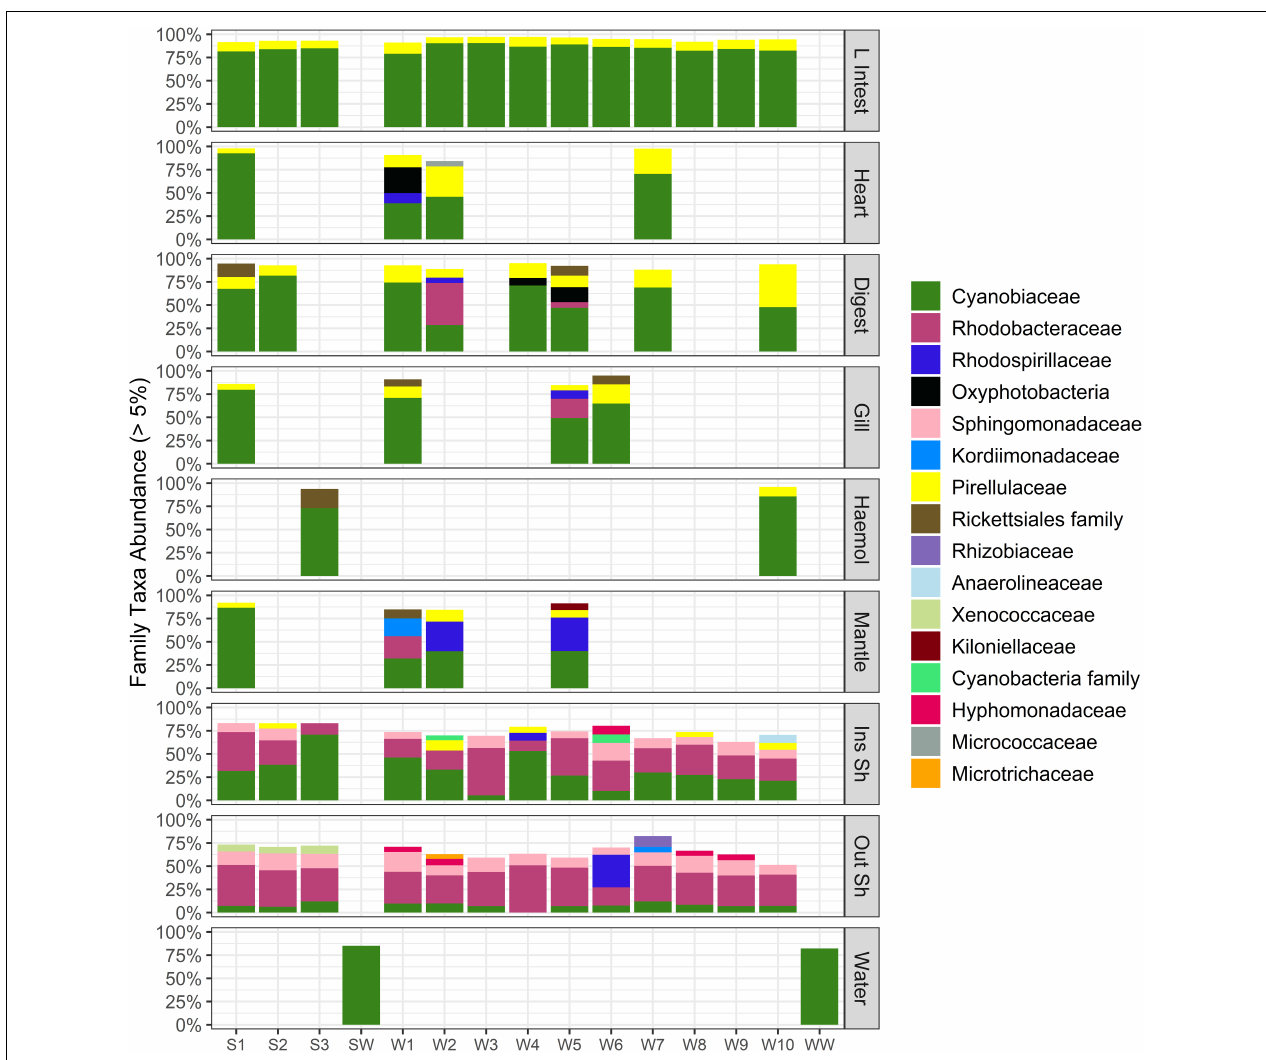
FIGURE 3 | Stacked bar plot of bacterial taxa at family level (relative abundance > 5%) across oyster tissue types and farm water. Each column is a sample. “L Intest” large intestinal tissue, “Digest” digestive tissue, “Haemol” haemolymph, “Ins Sh” inside shell, “Out Sh” outside shell, “Water” farm water. “S,” Seaflower Bay and “W,” Wargul Wargul Bay. Only samples with > 1220 sequence reads were